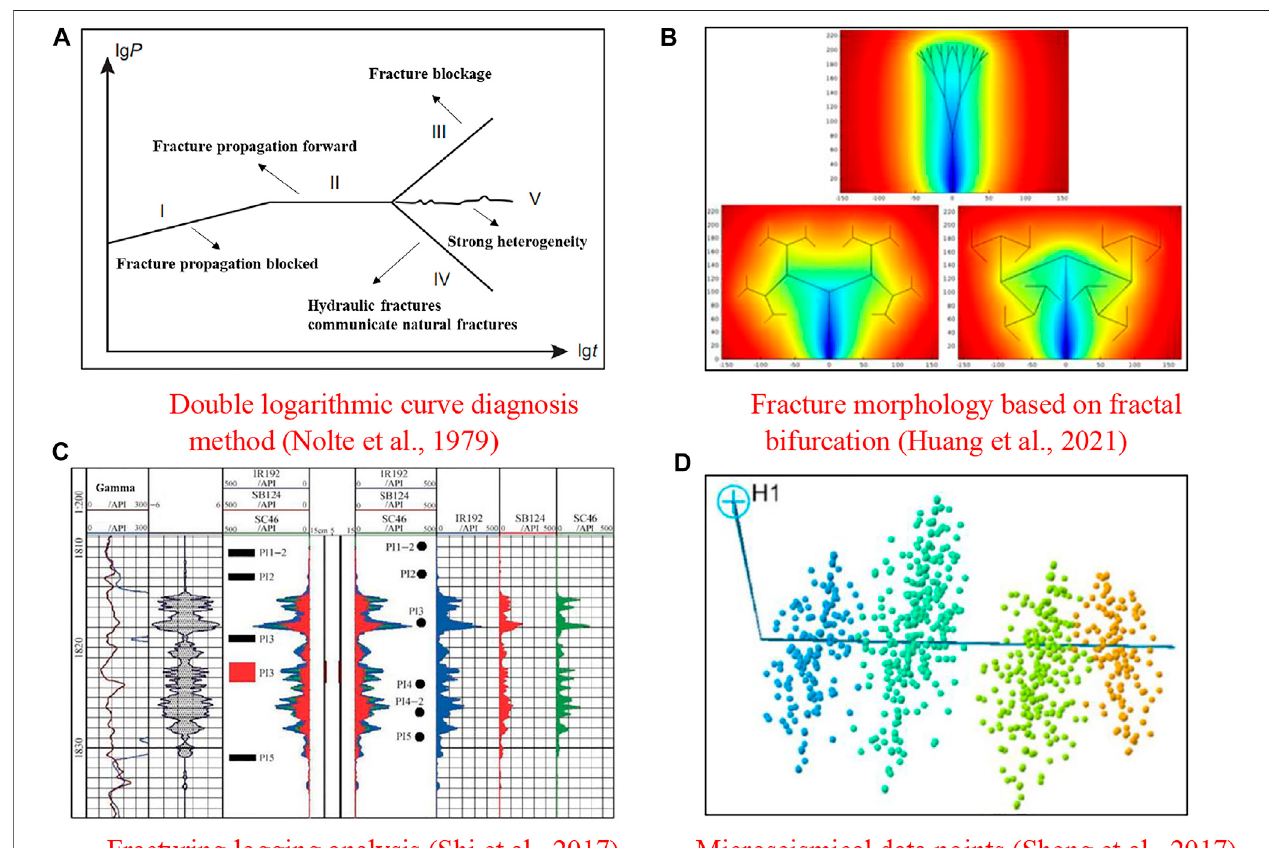
FIGURE 1 | Fracture diagnosis